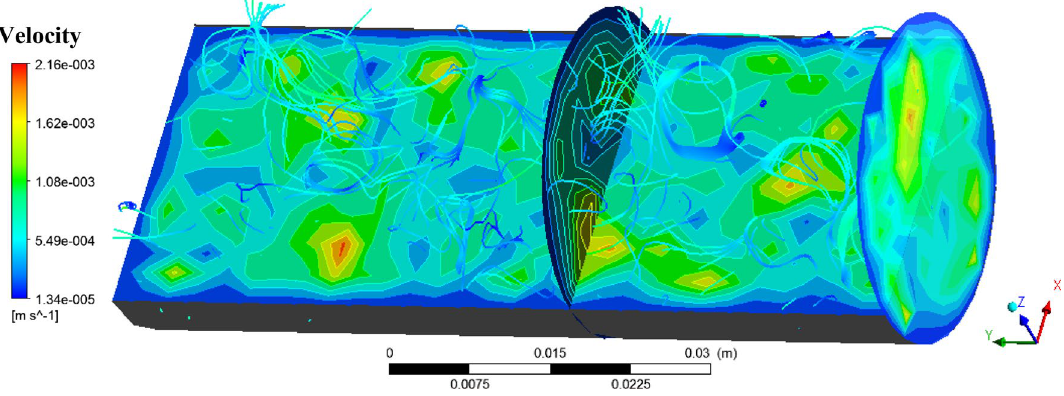
Fig. 7 Flow velocity profile across core sample before wax